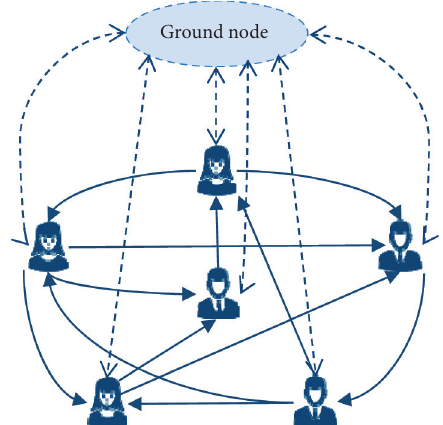
Figure 3: An illustration of the LeaderRank